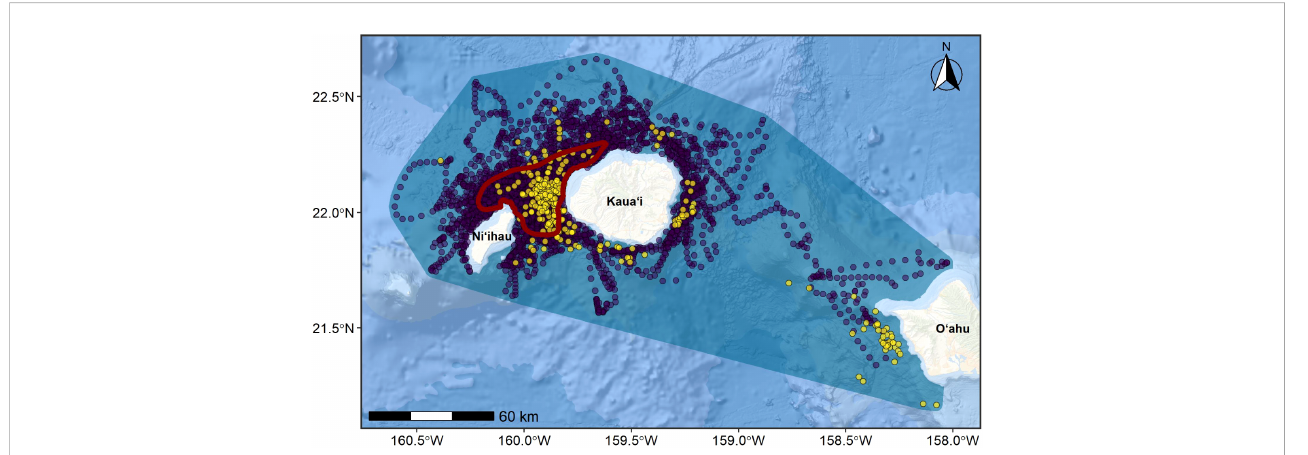
FIGURE 5 Parent BIA boundary (blue polygon) and child BIA boundary (core range; dark red polygon) for the KNO rough-toothed dolphin population, shown with all sighting locations (yellow circles) and hourly crawl- predicted tag locations (purple circles). Points are partially transparent to highlight high density areas (i.e., where multiple points overlap). The total area of the parent BIA = 25,083 km 2 and child BIA = 1,098 km 2 . Basemap image is the intellectual property of Esri and is used herein with permission. Copyright © 2022 Esri and its licensors. All rights